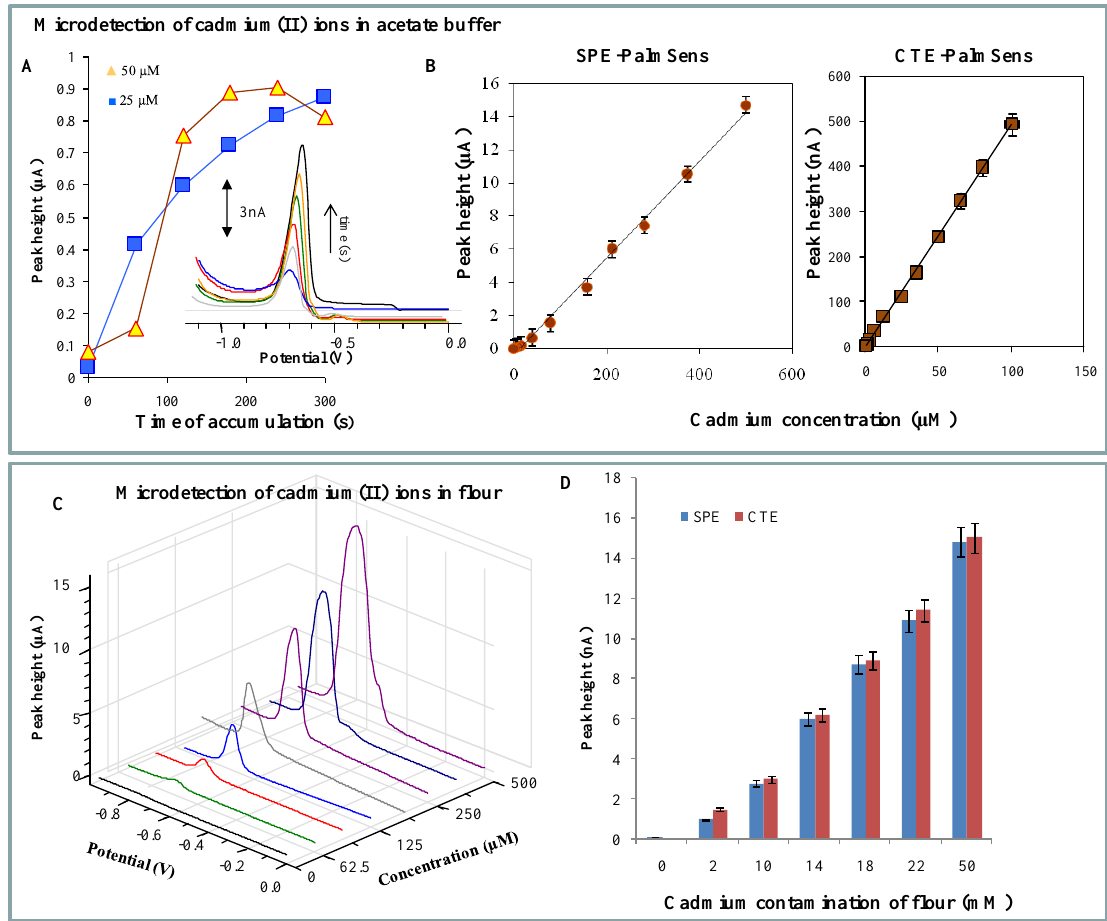
Figure 3. Differential pulse voltammetric detection of cadmium(II) ions at SPE and/or CTE connected to PalmSens potentiostat. (A) The dependence of cadmium(II) ions peak height on accumulation time (concentration of Cd(II) is 20 µM), in inset: typical DP voltammograms of cadmium(II) ions measured at various times of accumulation with CTE. (B, C) Calibration curves. (D) DP voltammograms of various concentrations of cadmium(II) ions measured with SPE. Experimental parameters were as follows: initial potential 0 V, end potential –0.8 V, potential step 5